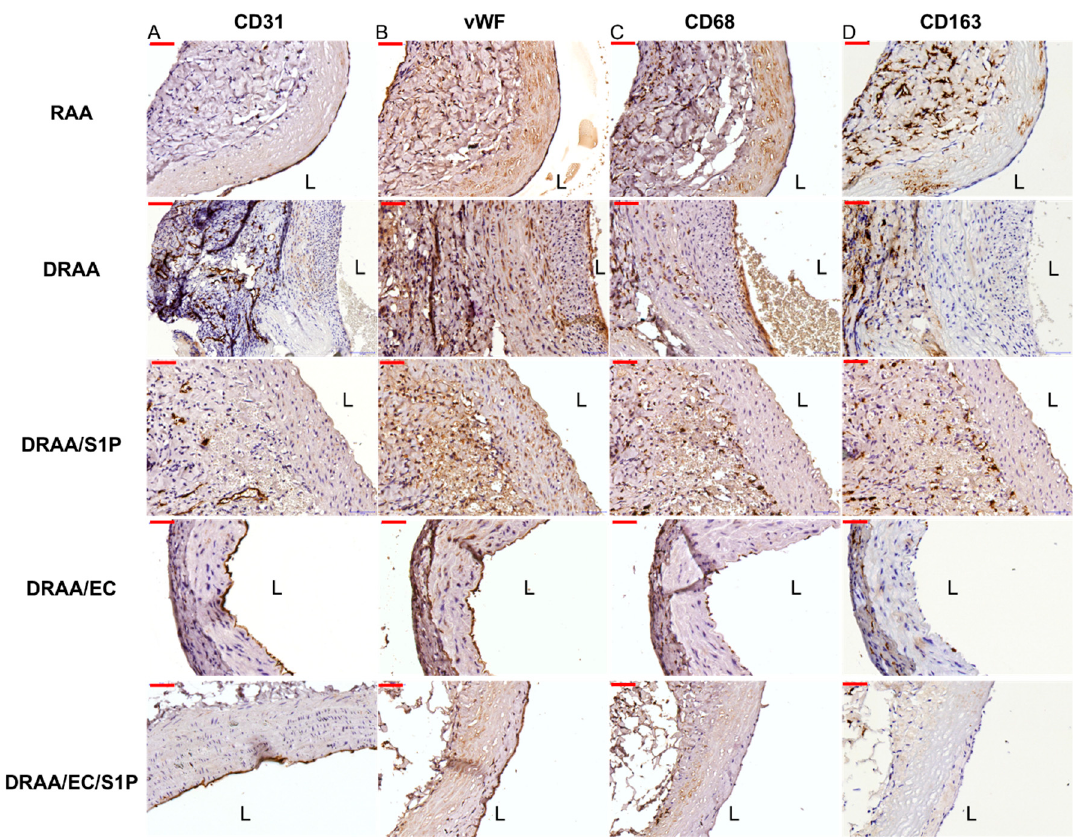
Figure 6. IHC staining of the explanted grafts at Day 14. Rat abdominal aorta stained using ( Panel A ) CD31; ( Panel B ), vWF; ( Panel C ), CD68; and ( Panel D ), CD163. (left column: RAA, left-middle column: DRAA, middle column: DRAA/S1P, right-middle column: DRAA/EC, and right column: DRAA/EC/S1P).Magnification all 400×, scale bar 50 µm. L, Lumen. n = 6 for RAA & DRAA/EC/S1P, n = 4 for DRAA/EC, n = 2 for DRAA/S1P and n =1 for DRAA.